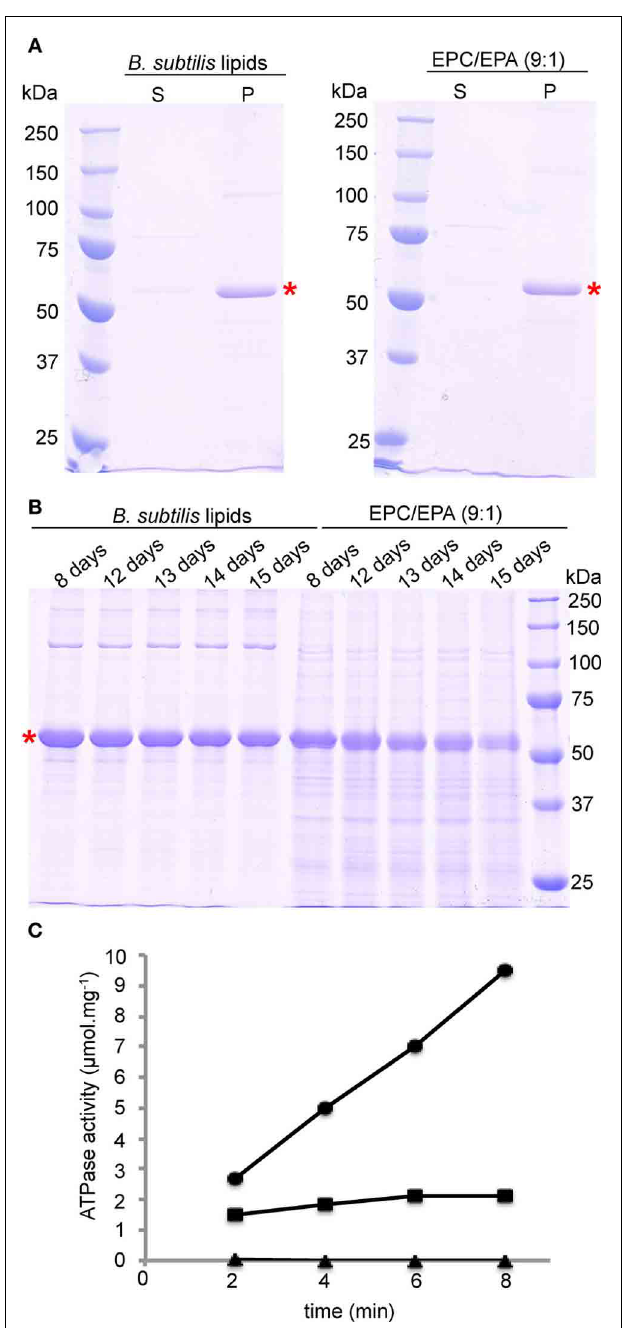
FIGURE 3 | Reconstitution and stability of BmrA in B. subtilis lipids and EPC/EPA (9:1) analyzed with SDS-PAGE. (A) After 9 days of dialysis, an aliquot was centrifuged at 20000 × g for the analysis of the supernatant (S) and the pellet (P). (B) For analysis of the stability of BmrA in the different lipid environments, after dialysis protein-lipid structures were incubated at room temperature and aliquots were analyzed by SDS-PAGE at the indicated times. BmrA is indicated by a red star. The SDS-PAGE gels (10% acrylamide) were stained with Coomassie brilliant blue. (C) Typical results for ATP hydrolysis by BmrA (dots) and its efficient inhibition by ortho-vanadate (rectangles). As a control BmrA was measured without additives (triangles). Samples were analyzed after 2, 4, 6, and 8min after addition of ATP/MgCl 2 .